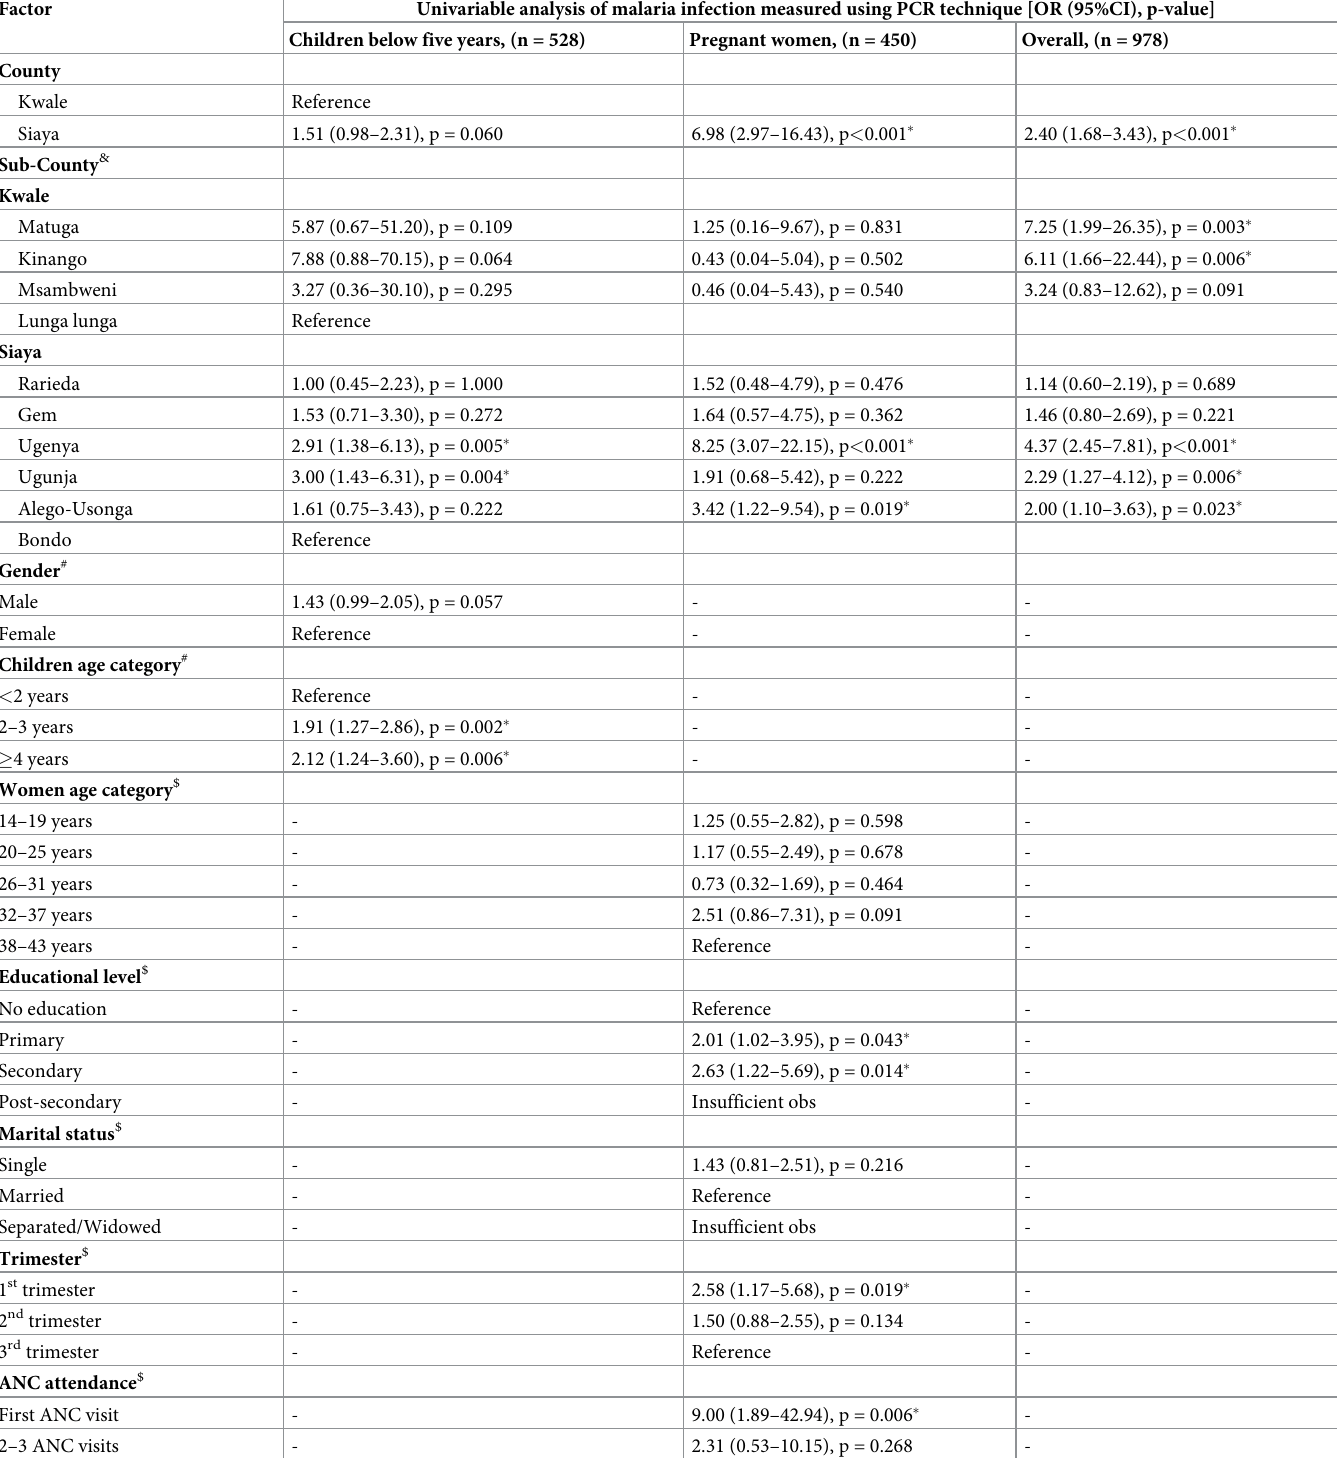
Table 3. Univariable analysis of factors associated with malaria infection (as measured using PCR technique) fitted separately for children below 5 years and preg- nant women in Kwale and Siaya counties,